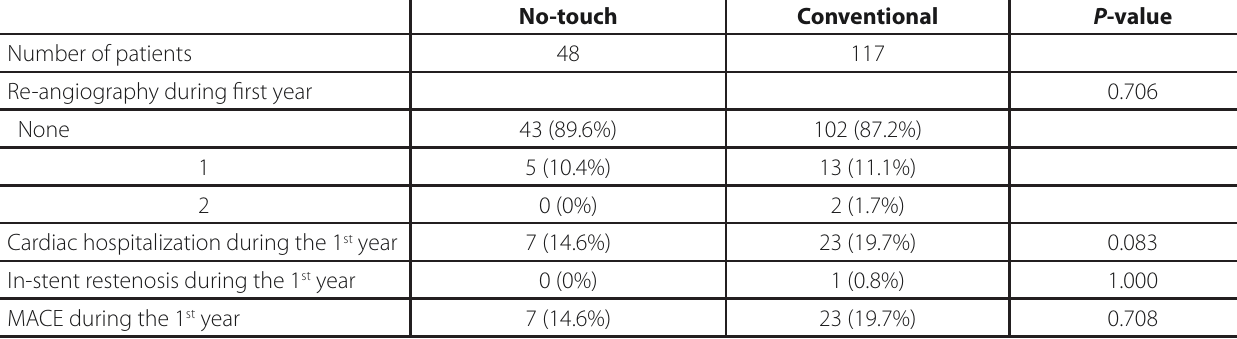
Table 3. Cardiac events at 1 year.